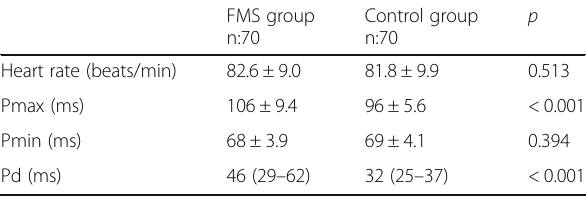
Table 4 Electrocardiographic parameters of FMS and control